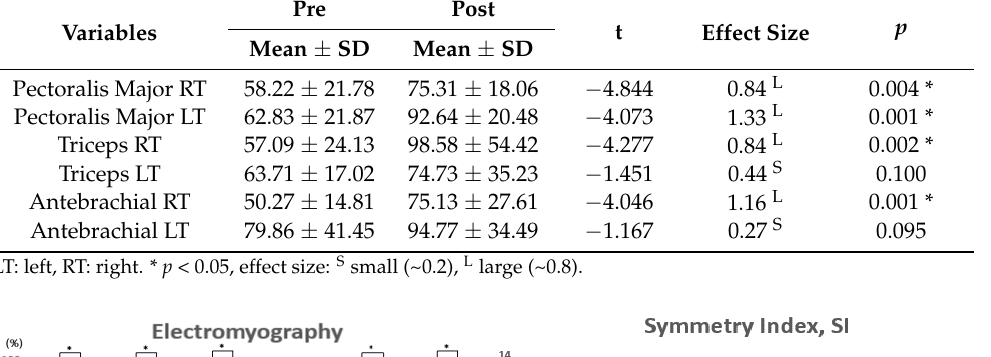
Table 2. Changes in muscle activity pre- and post-intervention on the left and right arms. Table 3. Left-to-right symmetry index (SI, %).